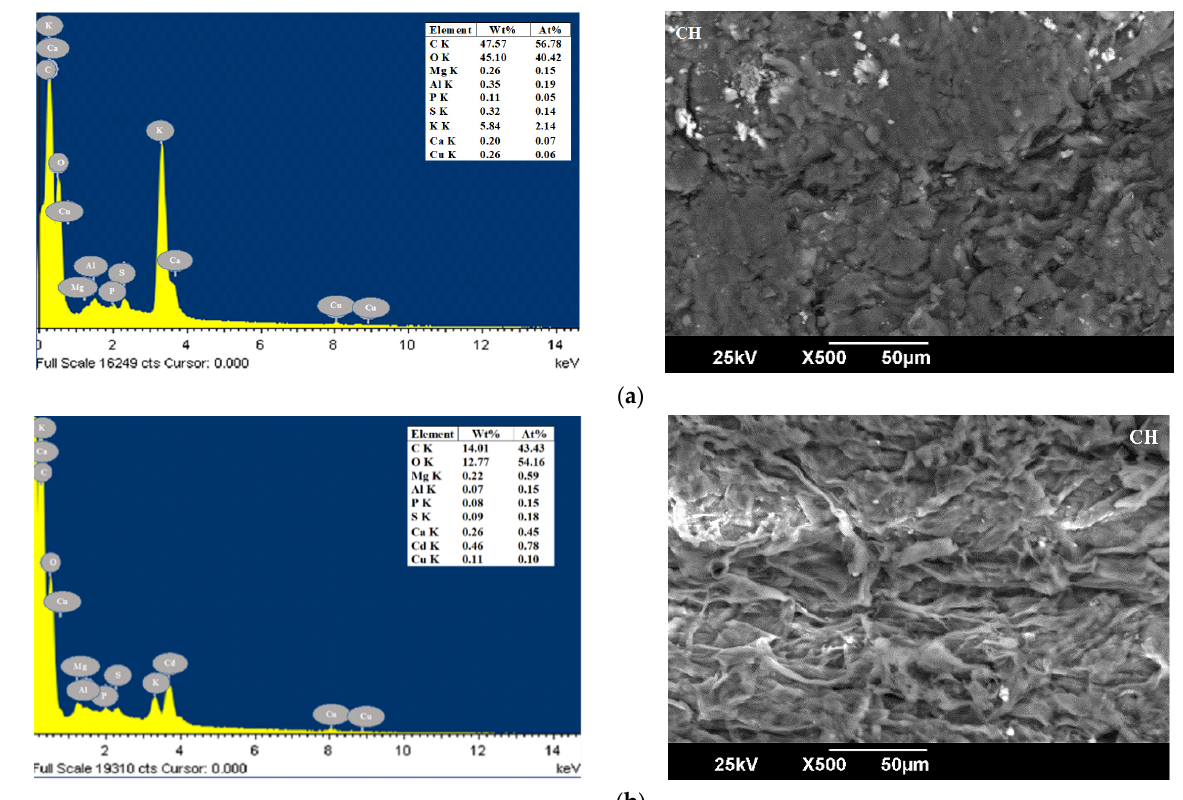
Figure 3. EDS spectra and -SEM micrographies for CH: ( a ) before and ( b ) after adsorption.